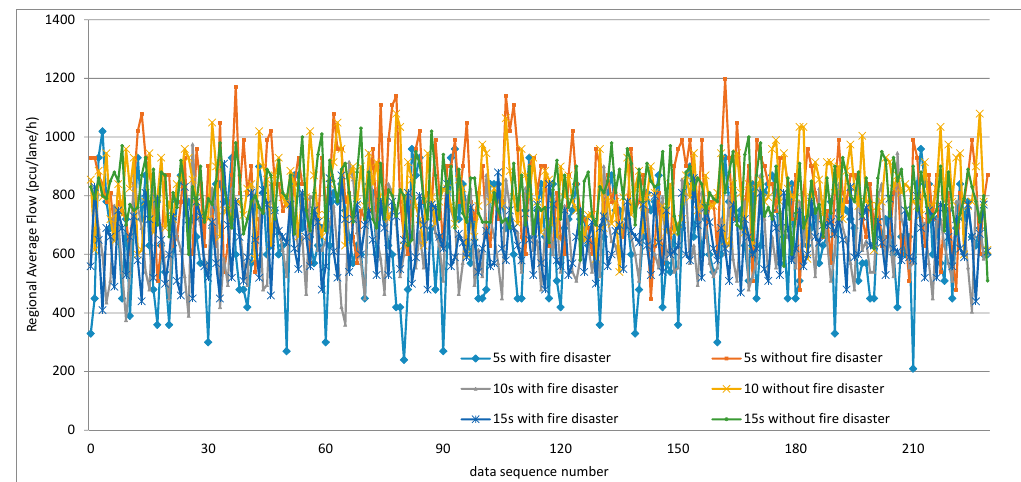
Figure 4. Dataset of regional average flow in different collecting time intervals with and without sudden fire disasters.